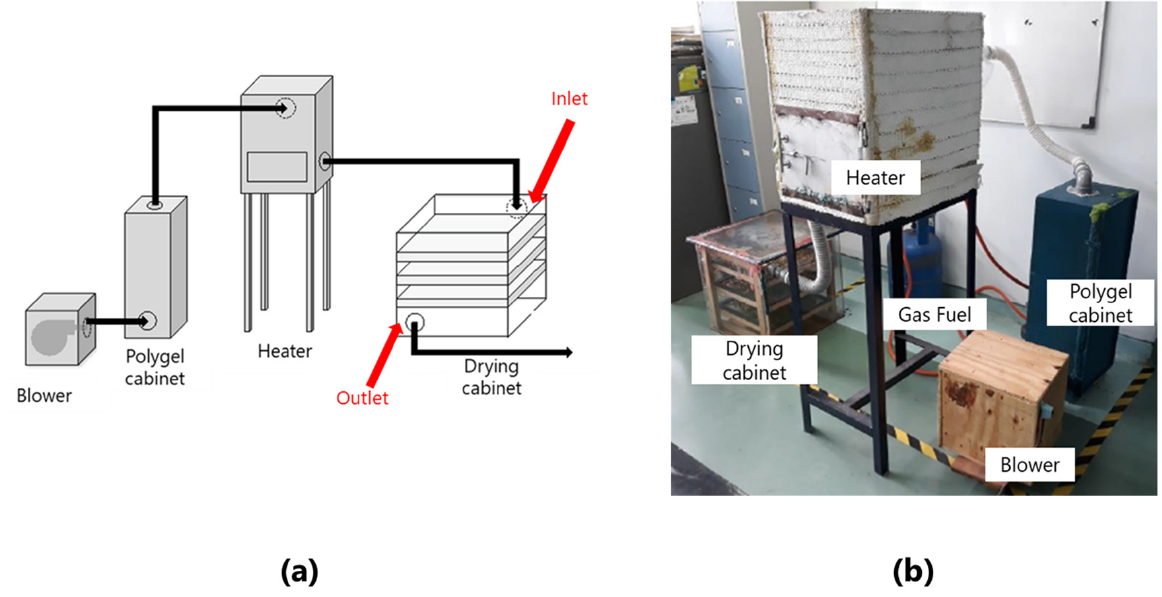
Figure 1. ( a ) Scheme and ( b ) photograph of Polydryer incorporated with a gas-fueled insulated heater.